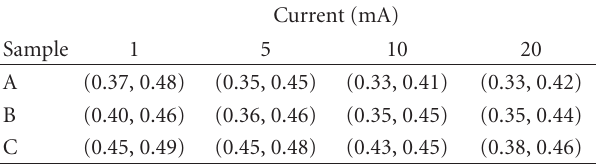
Table 1: CIE coordinate in all RGB-type samples.